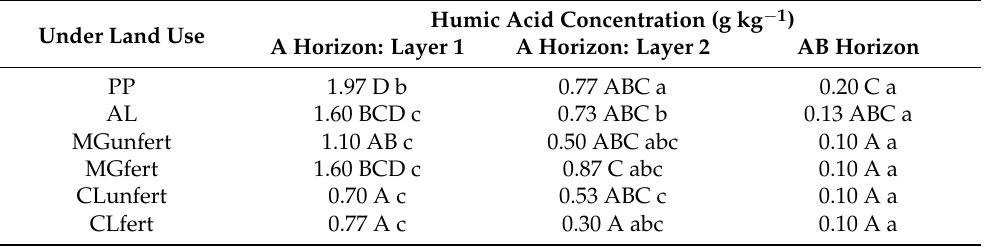
Table 5. Humic acid concentrations (g kg − 1 ) in different layers of soil of different types of land use. Humic Acid Concentration (g kg − 1 ) Under Land Use A Horizon: Layer 1 A Horizon: Layer 2 AB Horizon